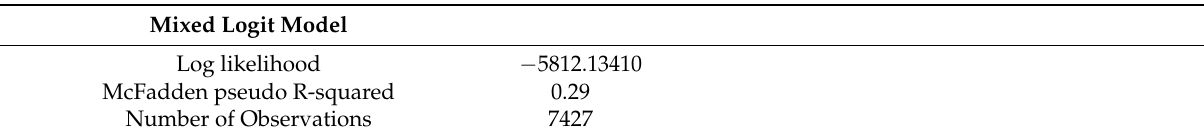
Table 6. Results of auto model